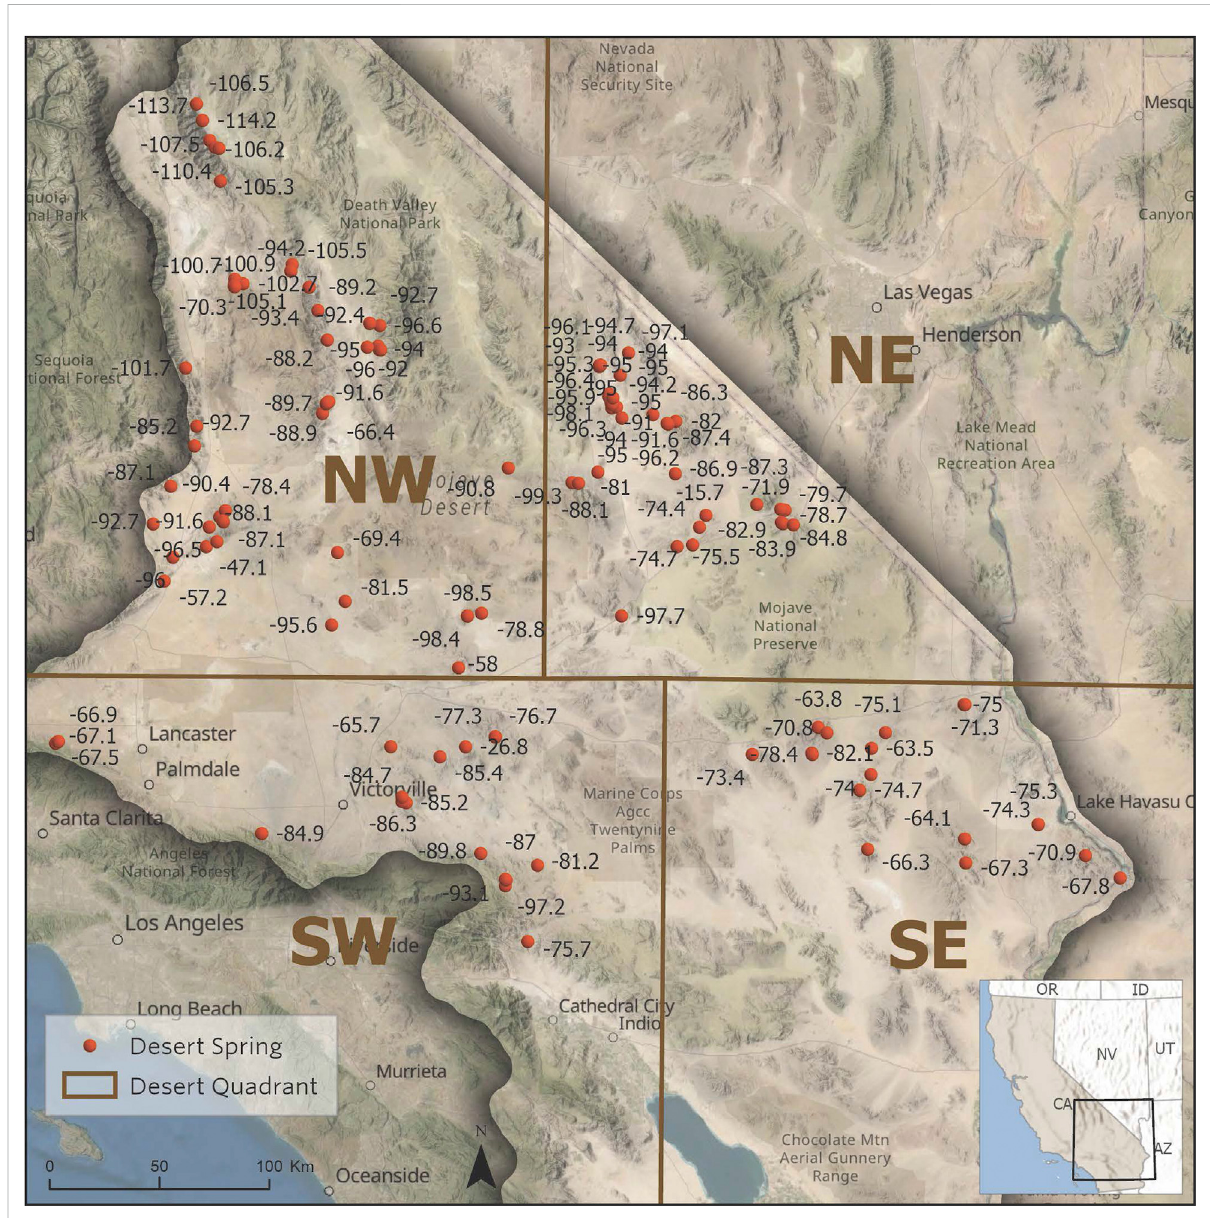
FIGURE 4 Quadrants of the California Desert region based on stable isotope abundances in desert springs (from Zdon,